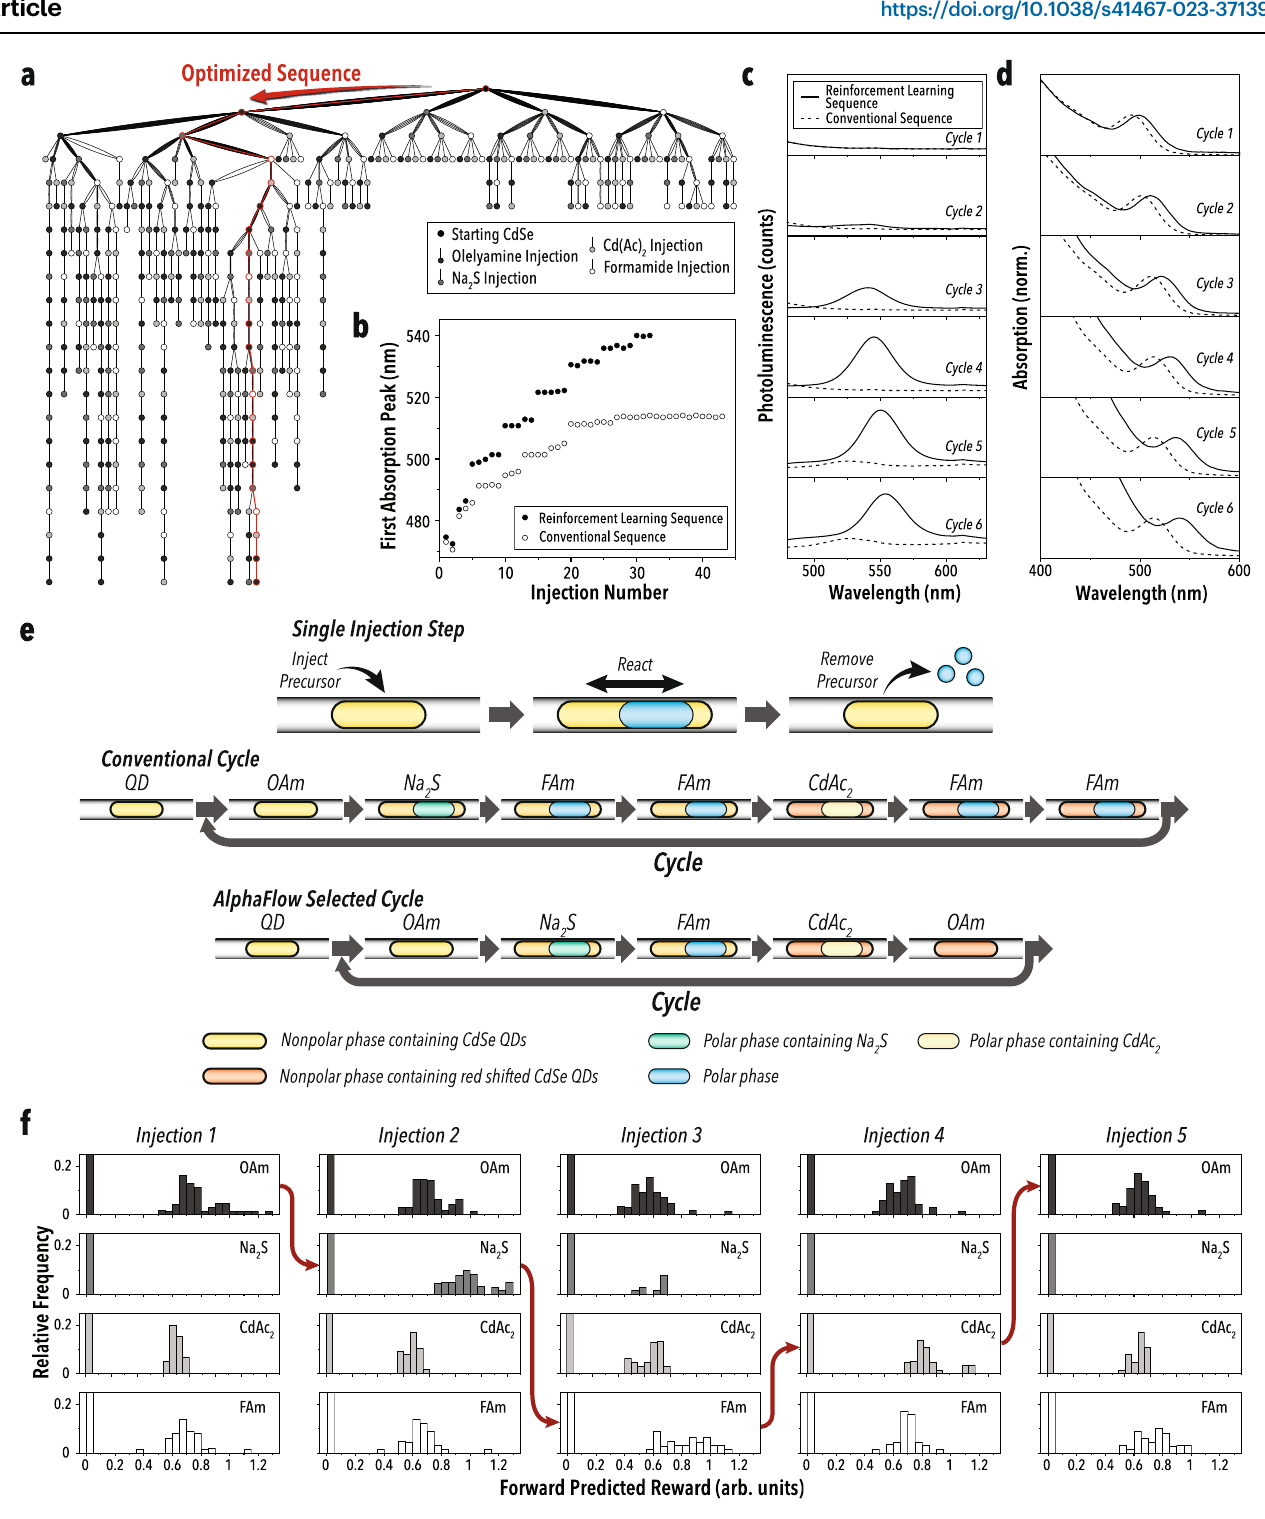
Fig. 3 | cALD sequence selection campaign results. a Illustration of all injection sequences in the exploration runs with the exploited sequence highlighted in red. b First absorption peak wavelength of CdSe/CdS hetero-nanostructures as a func- tionofinjectionnumberfortheRL-selectedcALDchemistryandthemanuallyinput conventional injection sequence. c UV-Vis photoluminescence and absorption ( d ) spectra after each full cALD cycle for the RL-discovered and conventional cALD sequences. e Schematic of reagent addition sequences for conventional cALD